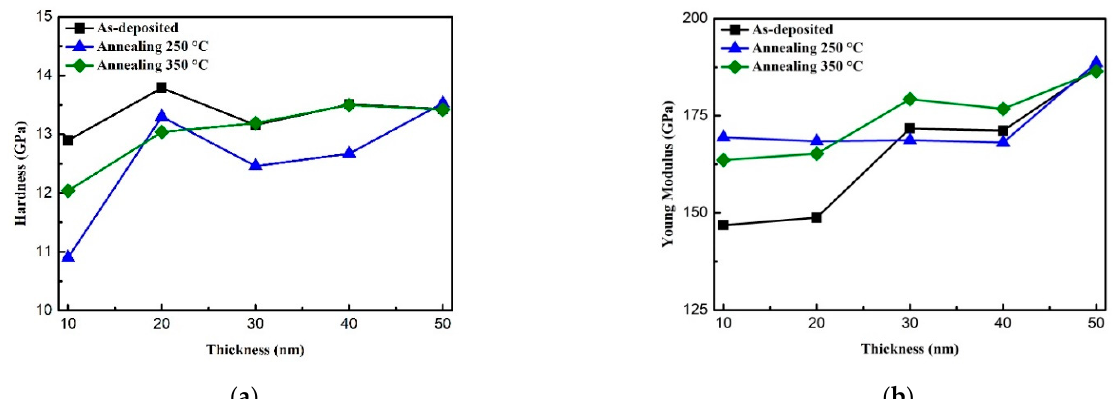
Figure 7. Nano-indentation of CoFeW films. ( a ) Hardness and ( b ) Young’s